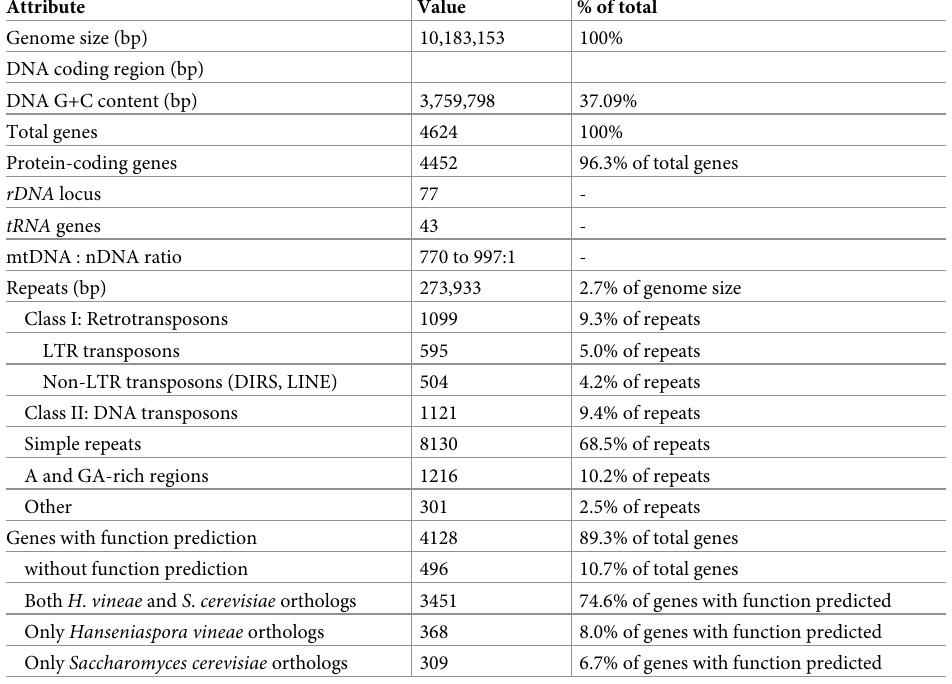
cannonical protein-coding genes (96.3%, Table 2). As introduced by Bellora et al. [44], by using the excess sequencing coverage of contigs for the mitochondrial genome (mtDNA) and rDNA loci, we estimated the copy number ratio of mtDNA per nDNA as 883:1 and the rDNA locus per nDNA as 77:1 in the genome of H . gamundiae CRUB 1928 T (Table 2). Next, the phylogenetic markers LSU D1/D2, ITS/5.8S, EF-1 α , and actin (KU674858, KU674846, KU674882K, and KU674870, respectively) were aligned to the genome sequences